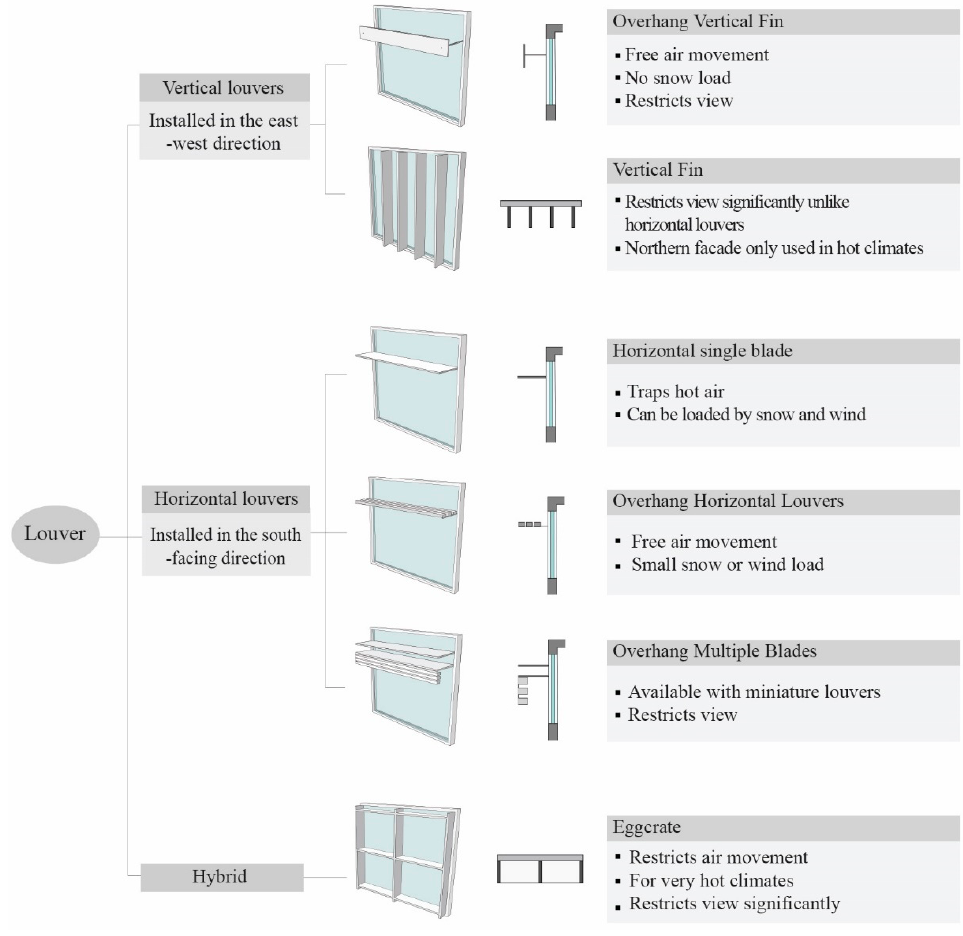
Figure 2. Types and characteristics of louvers. Table 1. Consideration of previous work on louver shading